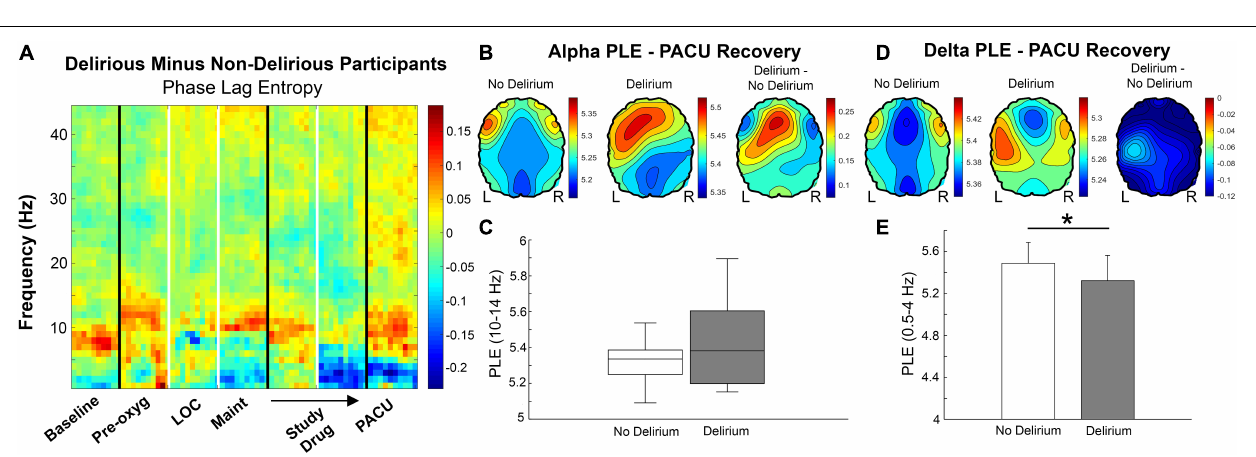
FIGURE 4 | Topography of phase lag entropy (2 – 20 Hz) presented. (A) At preoperative baseline, participants demonstrate relatively high frontal and central phase lag entropy compared to posterior regions. This anterior-posterior asymmetry, with relatively high phase lag entropy in anterior regions, appears more preserved in non-delirious participants compared to those with delirium during PACU recovery. (B) Relatively low phase lag entropy is present throughout anterior, central, and posterior regions in participants randomized to placebo, whereas relatively high anterior phase lag entropy is present with caffeine during PACU recovery.